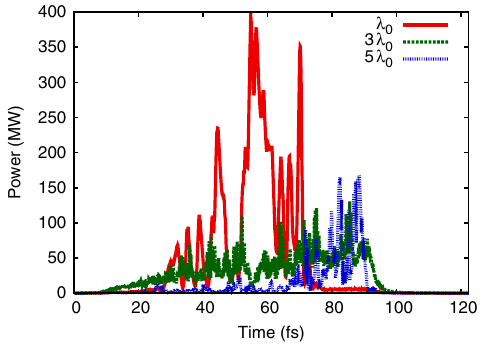
FIG. 21. Profile of the final output power produced at wave- lengths of 0.3 nm, 0.9 nm, and 1.5 nm for a start-to-end bunch with a vertical offset.